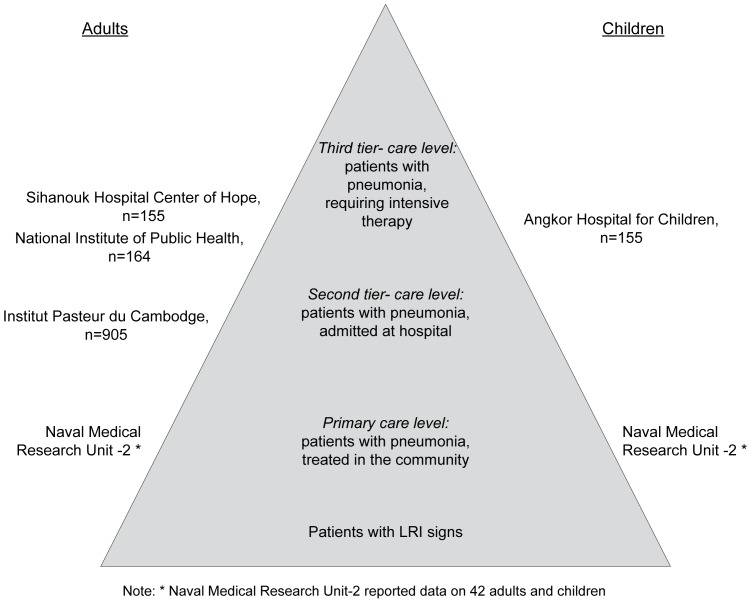
Unpublished Cambodian data sources.The Cambodian data sources were mapped within the pneumonia “iceberg”, adapted from Macfarlane [79].